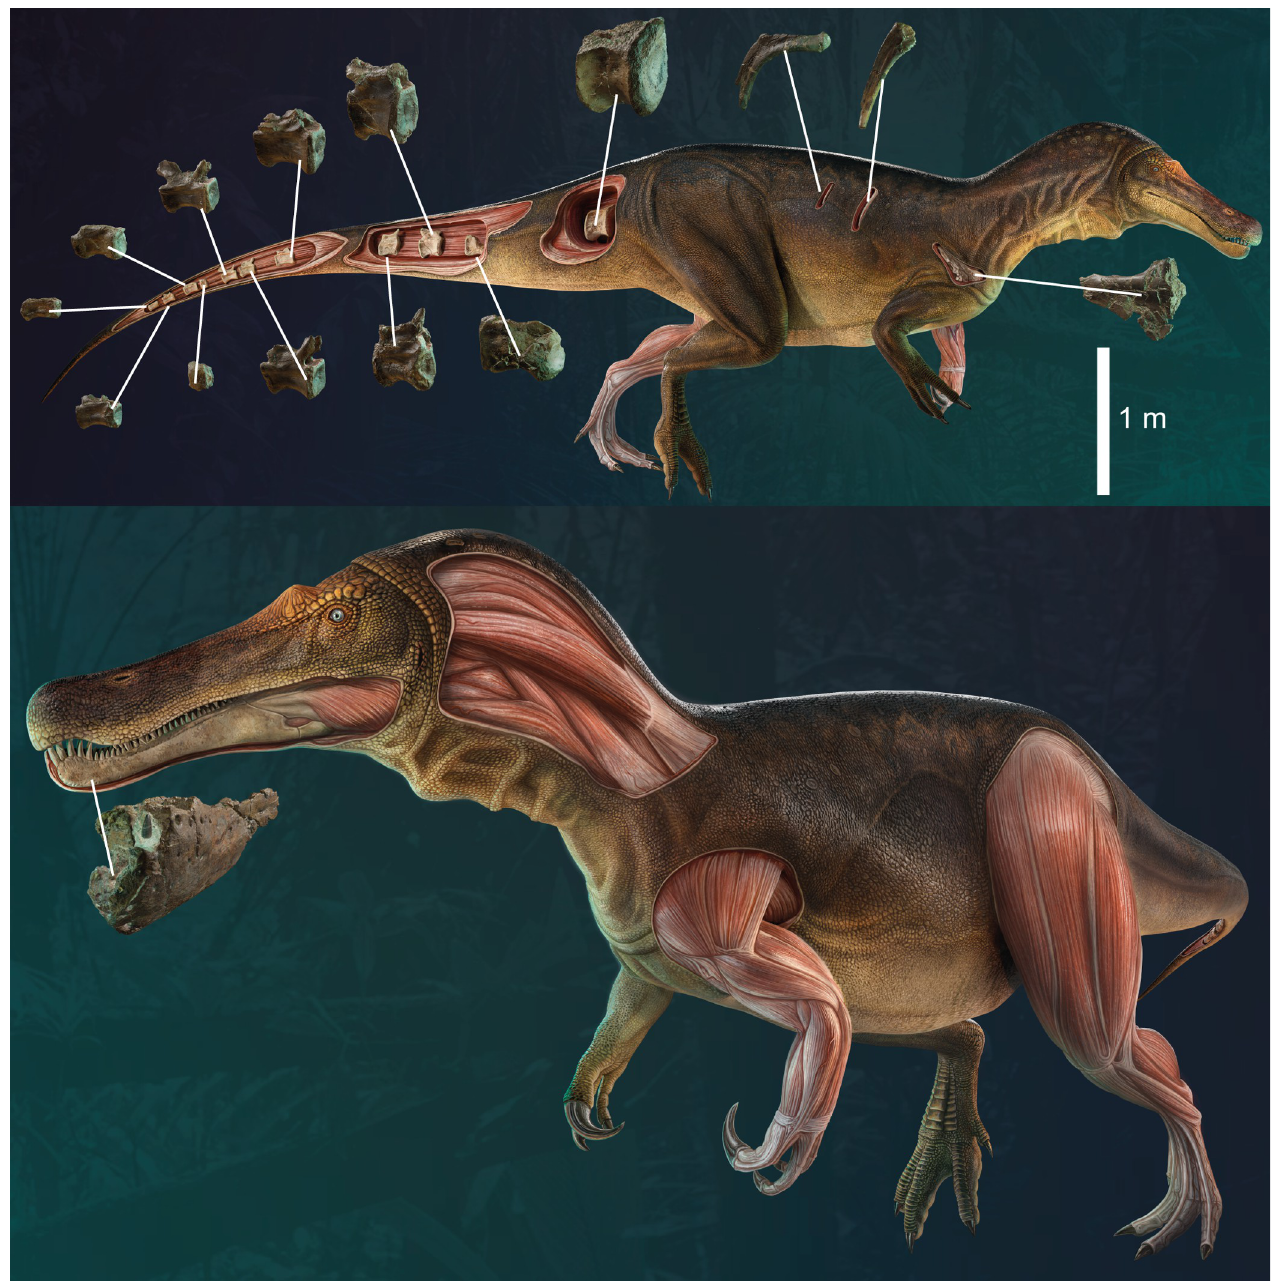
Fig 32. Life reconstruction of Iberospinus natarioi (ML1190) showing 3D digitalization of some of the recovered bones, along with reconstructed musculature. Upper , right lateral view; Bottom , anterolateral left view. Paleoart by Victor Feijo´ de